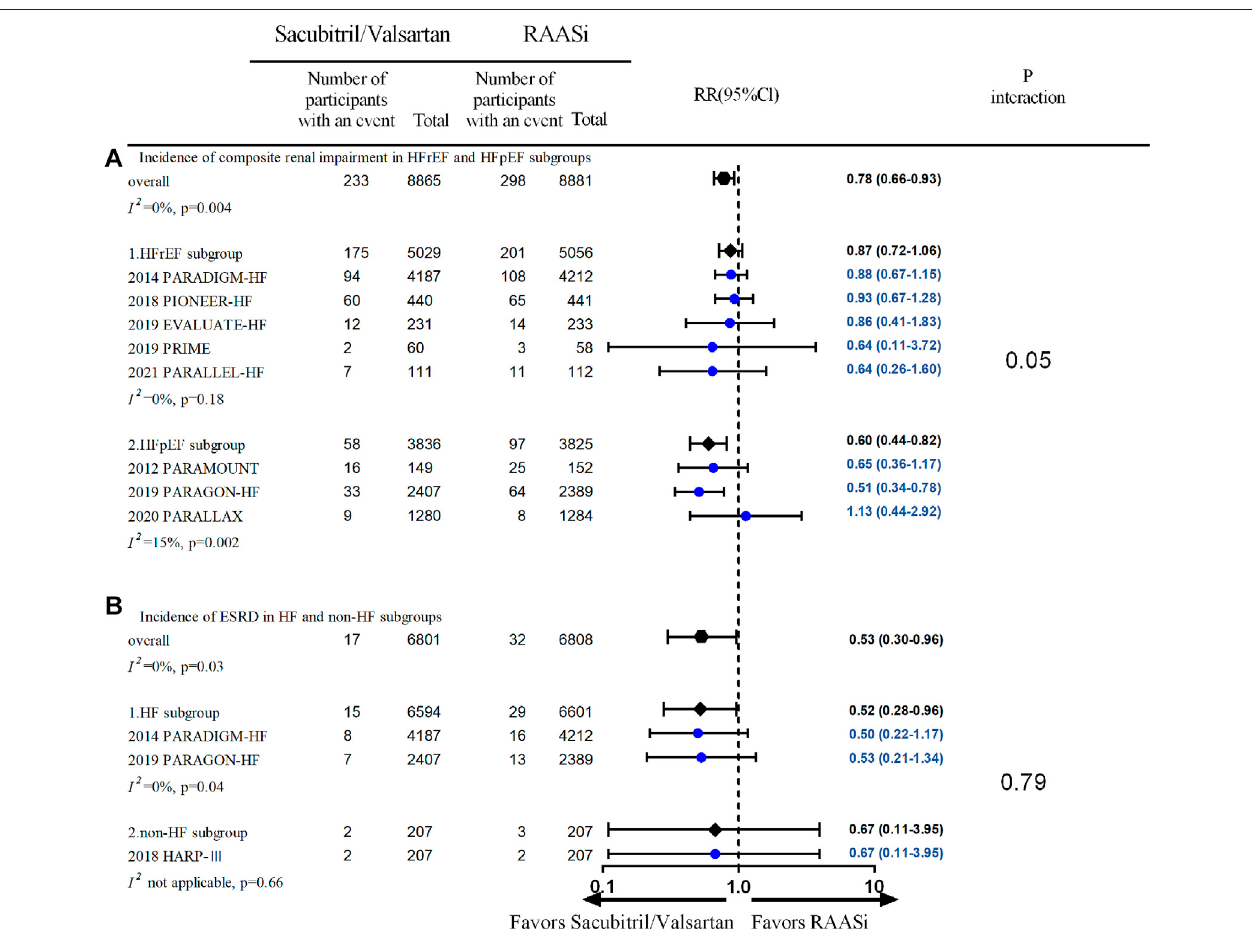
FIGURE 3 | (A) Incidence of composite renal impairment in HFrEF and HFpEF subgroups — outcomes were from fi xed-effect meta-analysis. RAASi, renin – angiotensin – aldosteronesysteminhibitor;RR,relativeratio;HFrEF,heartfailurewithreducedejectionfraction;HFpEF,heartfailurewithpreservedejectionfraction. (B) Incidence of ESRD in HF and non-HF subgroups — outcomes were from fi xed-effect meta-analysis. ESRD, end-stage renal disease; RR, relative ratio; HFrEF, heart failure with reduced ejection fraction; HFpEF, heart failure with preserved ejection fraction; RAASi, renin – angiotensin – aldosterone system inhibitor.